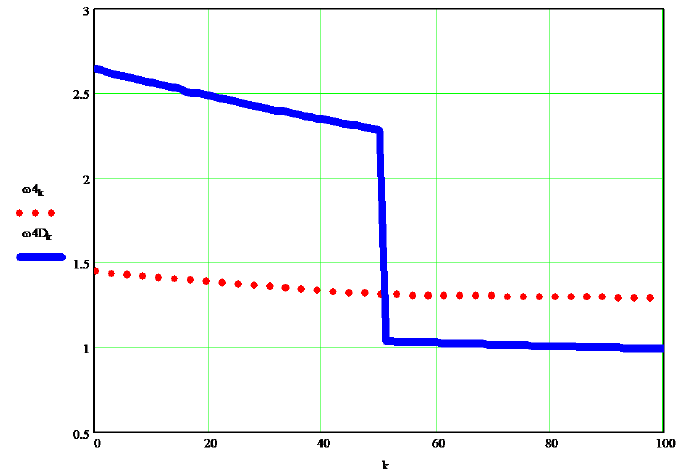
Figure 19. The dynamic angular speed of element 4 of the articulated robot, compared to the input (kinematics) considered speed (to a 6R2T robot).